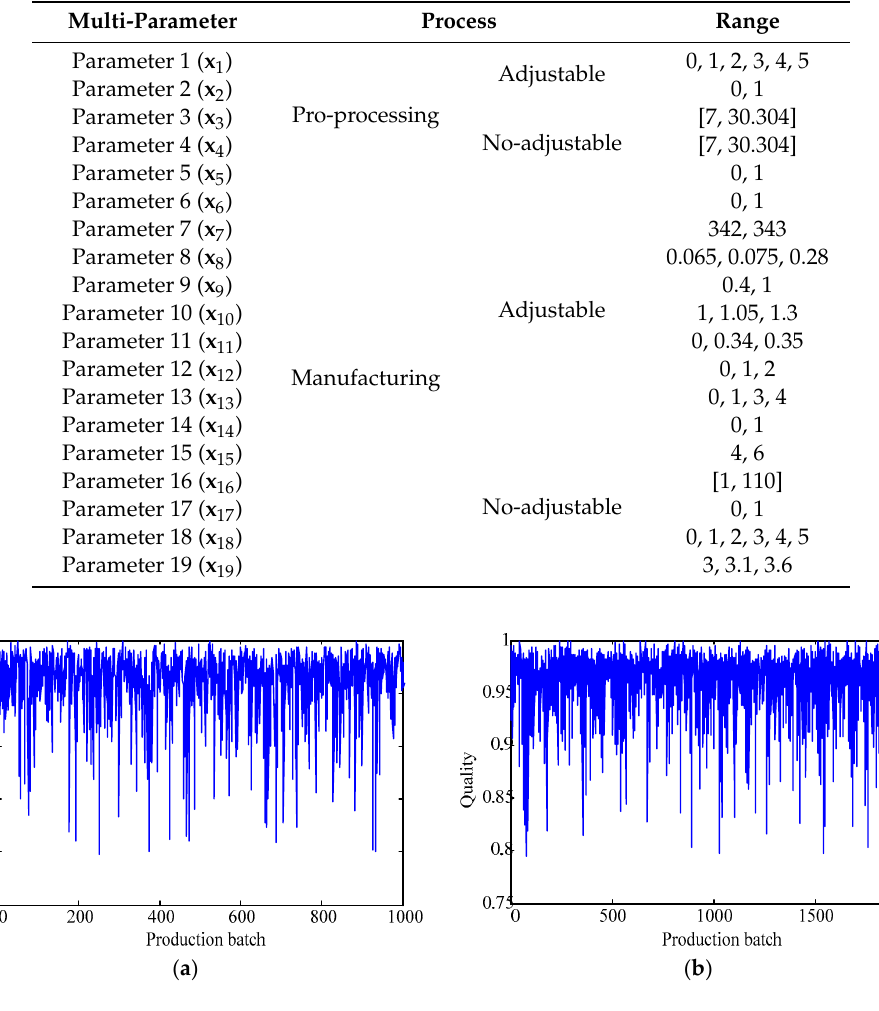
Figure 3. Manufacturing quality of different batches: ( a ) Case 1 and ( b ) Case 2.